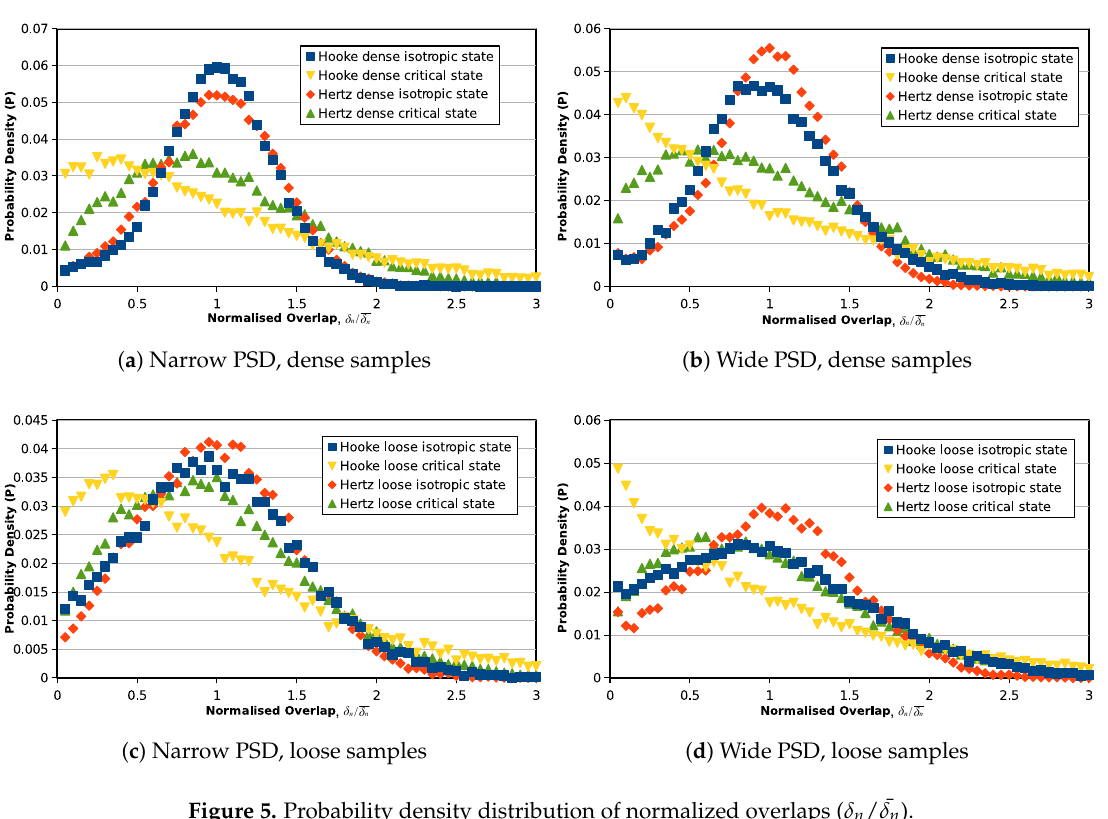
Figure 5. Probability density distribution of normalized overlaps ( δ n / ¯ δ n ).